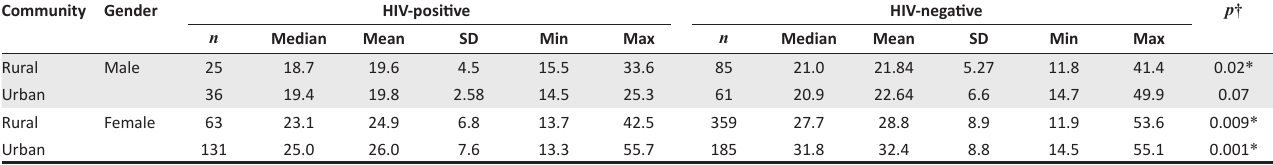
TABLE 4: Body mass index of HIV-infected and HIV-uninfected participants in rural and urban communities. Community Gender HIV-positive